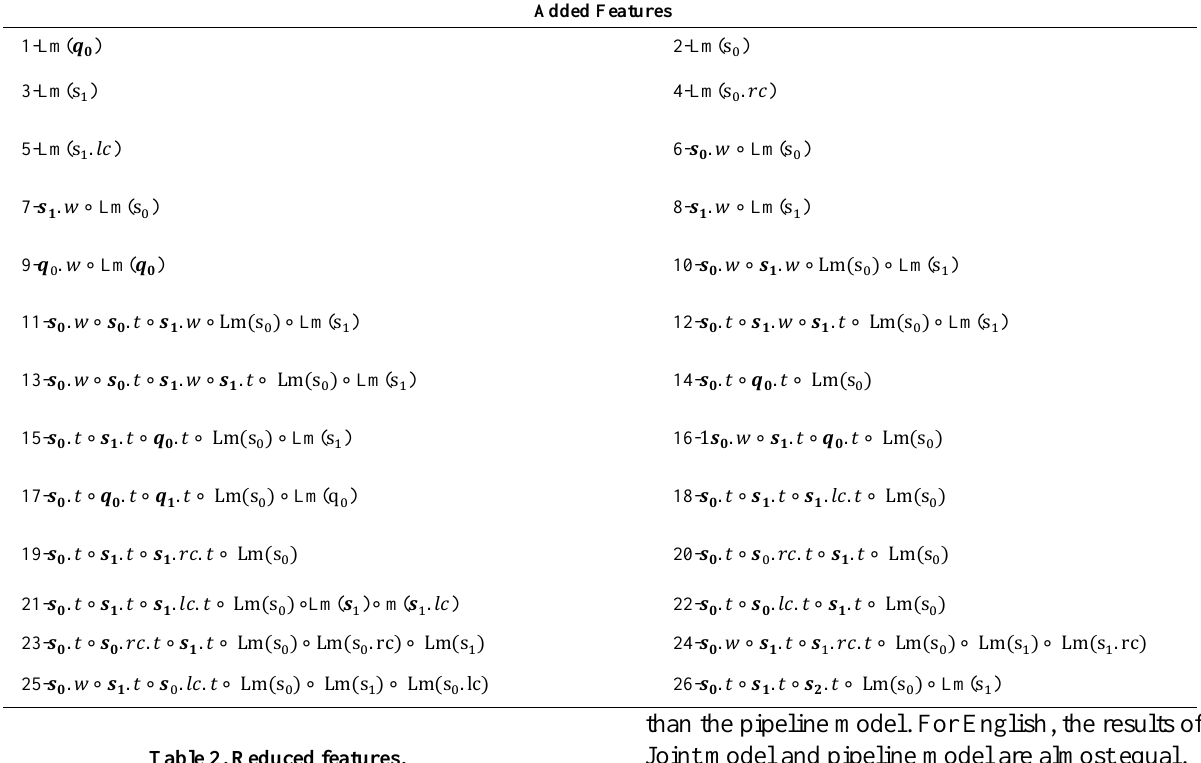
Table 1. Added Features- Lm denotes Lemma, s.w. and s.t. are the Form and Tag of the Root Word of Tree s, s.rc and s.lc are the Right- and Left-most Children of s, and ∘ Denotes the conjunction of Features.